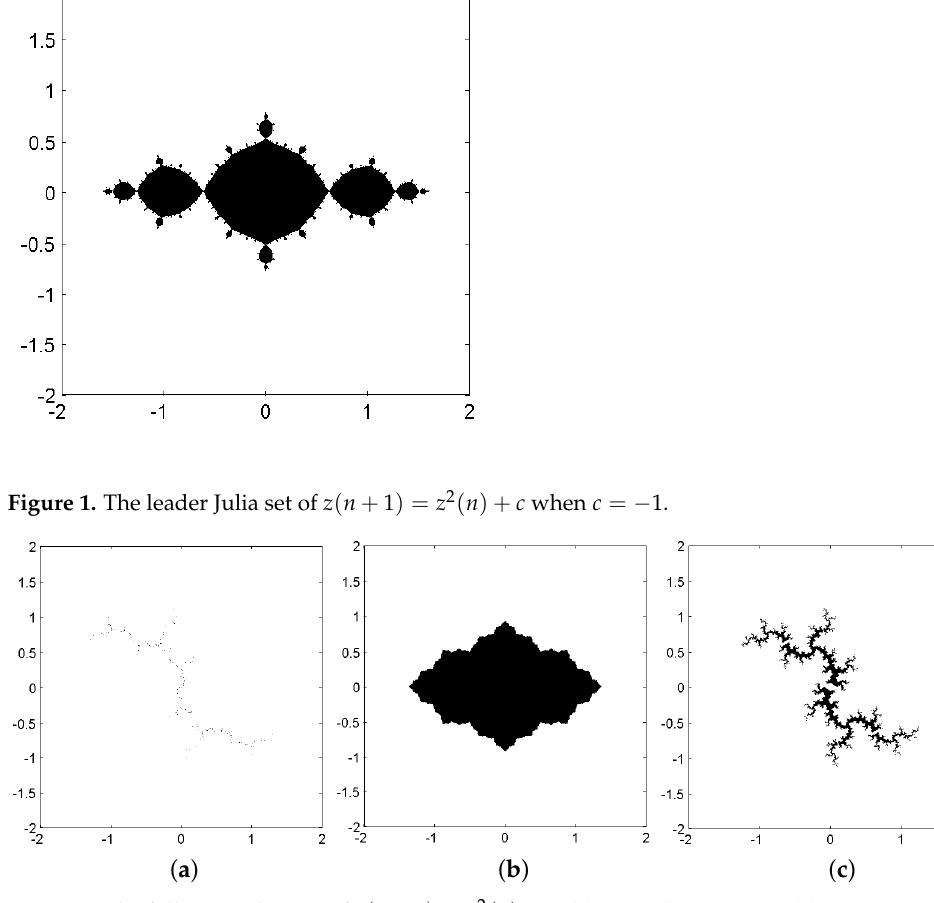
Figure 2. The follower Julia sets of z ( n + 1 ) = z 2 ( n ) + c . ( a ) c = i , ( b ) c = − 0.5, ( c ) c = 0.8 i